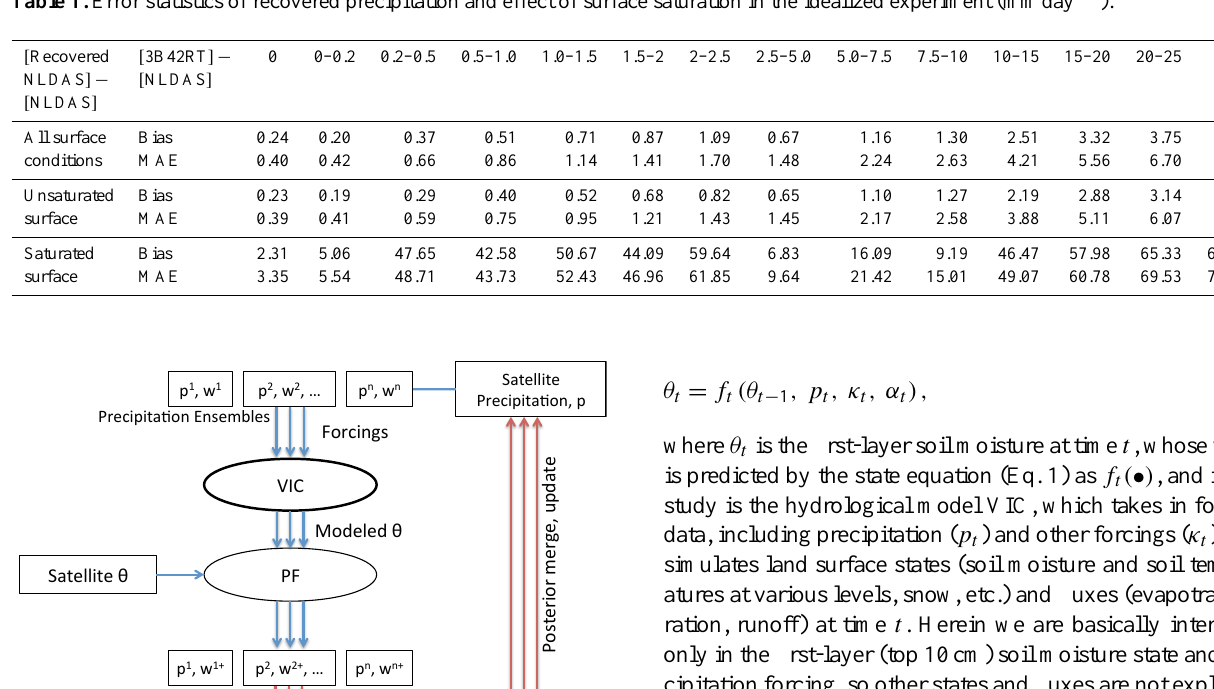
Table 1. Error statistics of recovered precipitation and effect of surface saturation in the idealized experiment (mmday − 1 ).